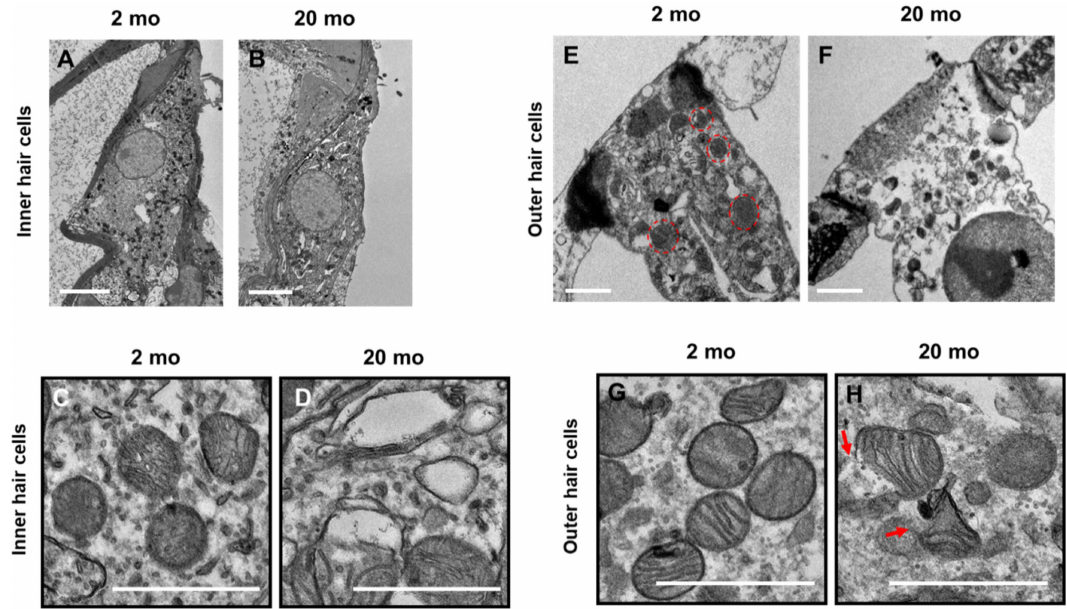
Figure 4. Ultrastructural analysis of cochlear inner and outer hair cells from young and aged mice. ( A – D ) Young inner hair cells show normal appearing mitochondria ( A ) with well-defined lamellar cristae ( C ), while old ones present numerous vacuoles in the cytoplasm ( B ) and damaged mitochondria with absent or disorganized cristae ( D ). ( E , G ) Normal outer hair cells with distinct mitochondrial cristae from young cochlea. ( F ) Outer hair cells of aging cochlea show “swollen” cell body and chromatin compaction. Their mitochondria appear enlarged and present altered cristae and a broken / bursting wall ( H ), arrows). Scale bar of ( A , B ) represents 5 µ m and of C–H represents 1 µ m.